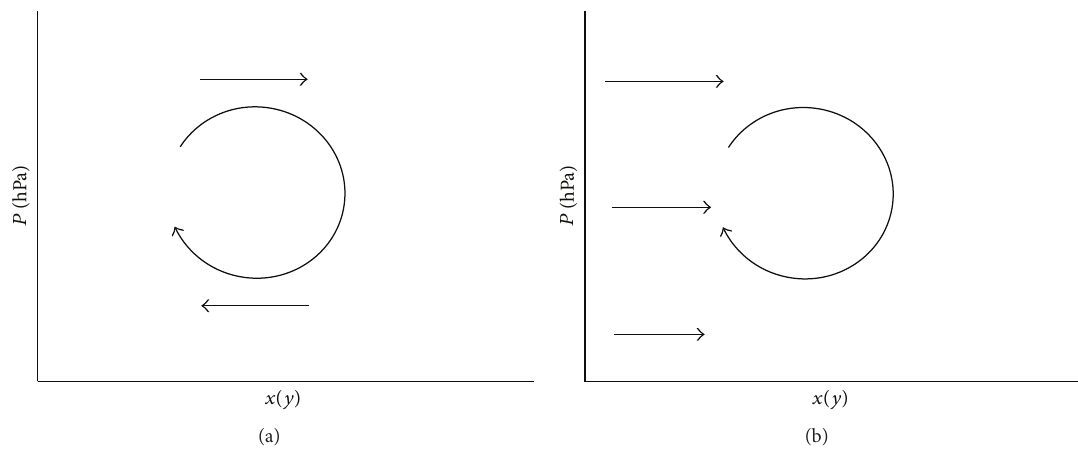
Figure 2: Clockwise form of tumble: (a) easterly (southerly) wind in the low atmosphere and westerly (northerly) wind in the high atmosphere; (b) westerly (northerly) wind in both the low and high regions of the atmosphere.